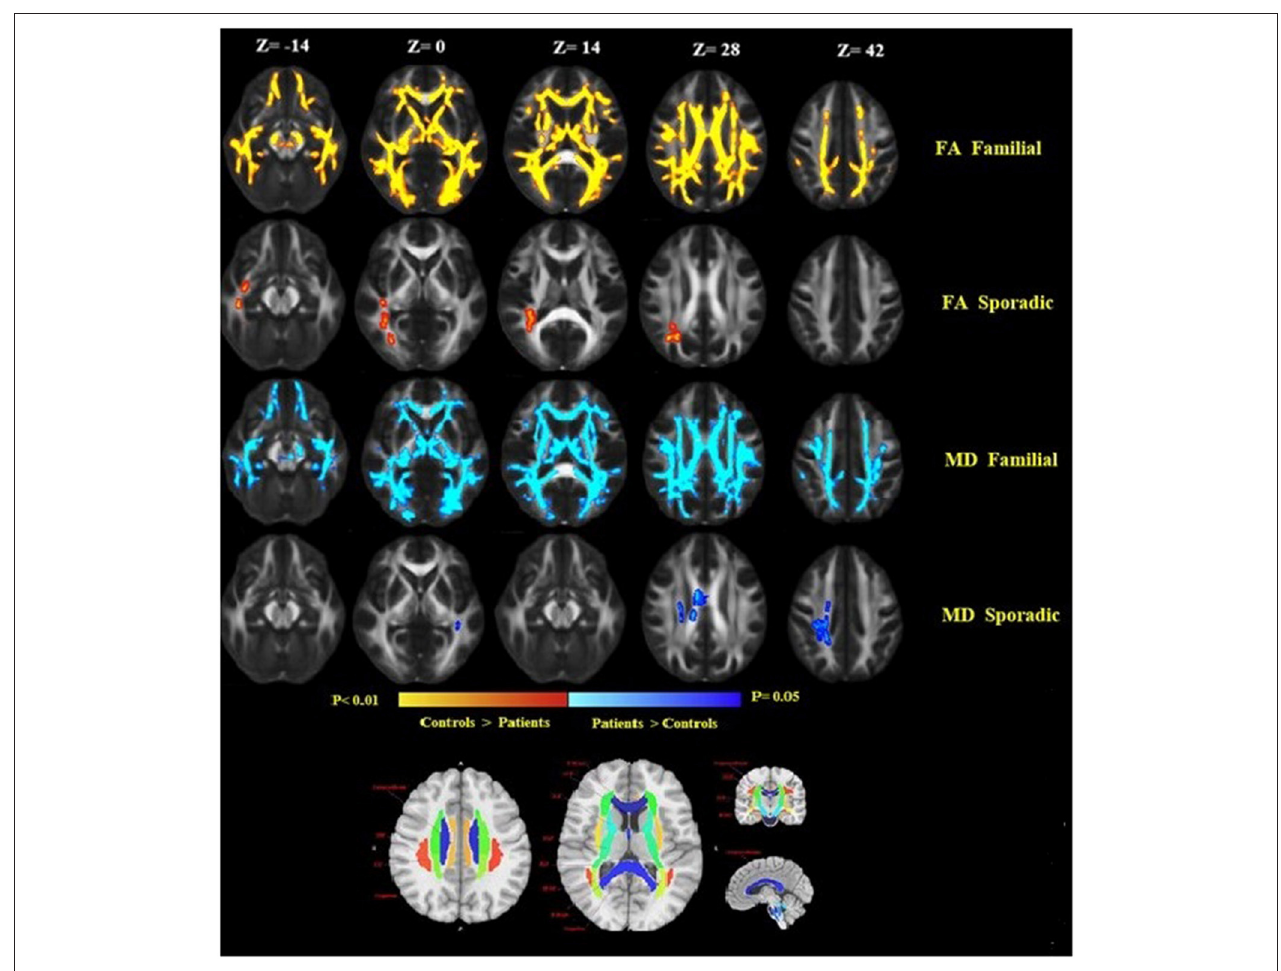
FIGURE 3 | Widespread alterations in DTI-derived fractional anisotropy (FA) and mean diffusivity (MD) found in patients as demonstrated by TBSS. FA and MD show regional differences in patients as compared to healthy controls. FA is lower throughout the white matter in patients as compared to healthy controls, while MD increased in patients compared to controls. Significant changes in FA and MD were found in the familial group, reflecting widespread disruption of white matter. Images are displayed in radiological convention with a left hemisphere on the right side. DTI location changes in FA and MD are presented based on an anatomical atlas (JHU White Matter Tractography Atlas). Fmajor, forceps major; Fminor, forceps minor; ATR, anterior thalamic radiation; CST, corticospinal tract; ILF, inferior longitudinal fasciculus; SLF, superior longitudinal fasciculus; IFOF, inferior-fronto-occipital